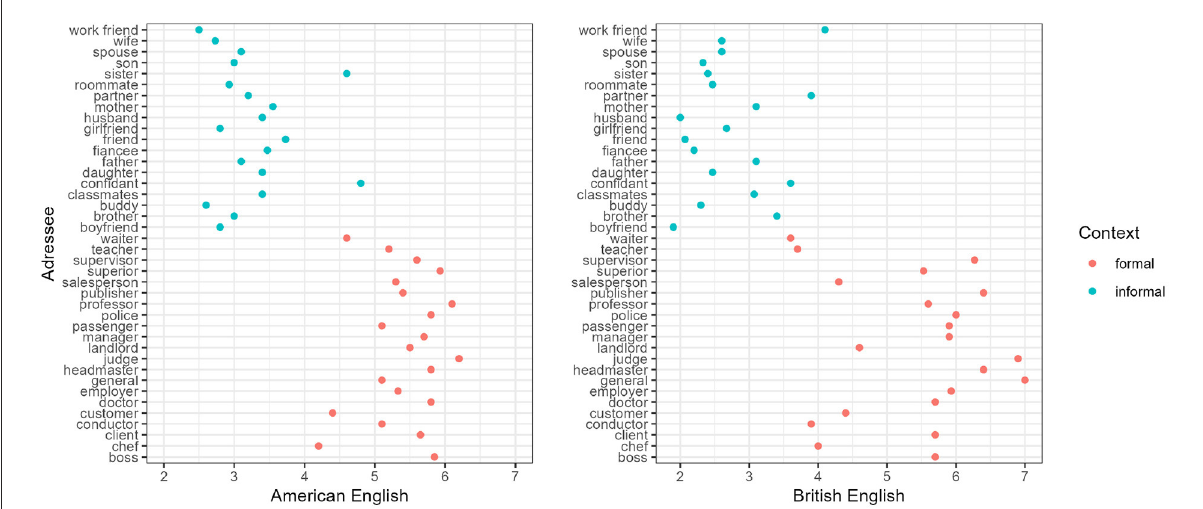
FIGURE8 Project A07: Pre-test results of 40 formality manipulations using social relations of the interlocutors and 10 participants for American English and British English each. Participants read short stories, e.g., “George Henderson works in a shop. The shop is deserted. He says to his manager/mother:” and subsequently answered questions, e.g., “Is George Henderson going to talk formally?” on a 7-point Likert scale.